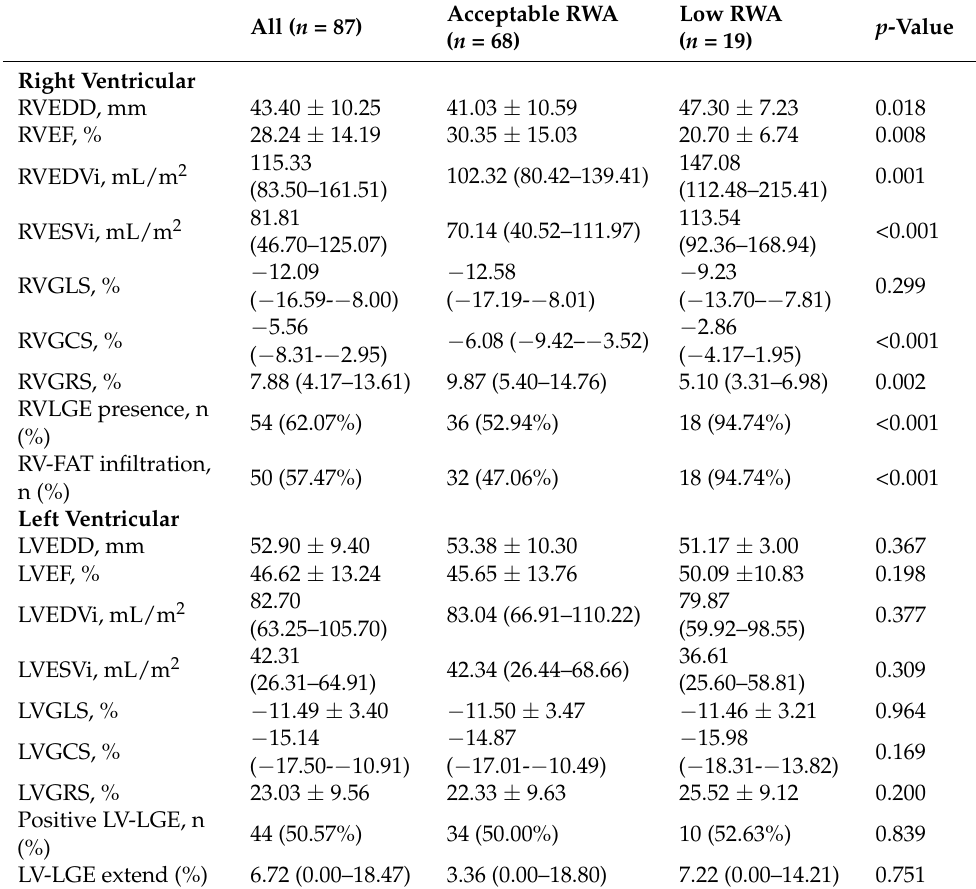
Table 2. Ventricular morphology and function evaluated by CMR.